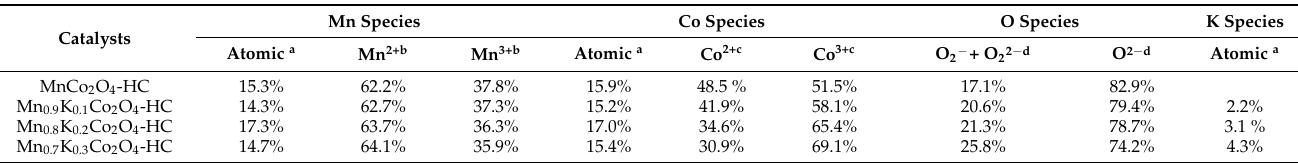
Table 4. XPS results for transition metal valence and surface oxygen species of as-prepared monolith